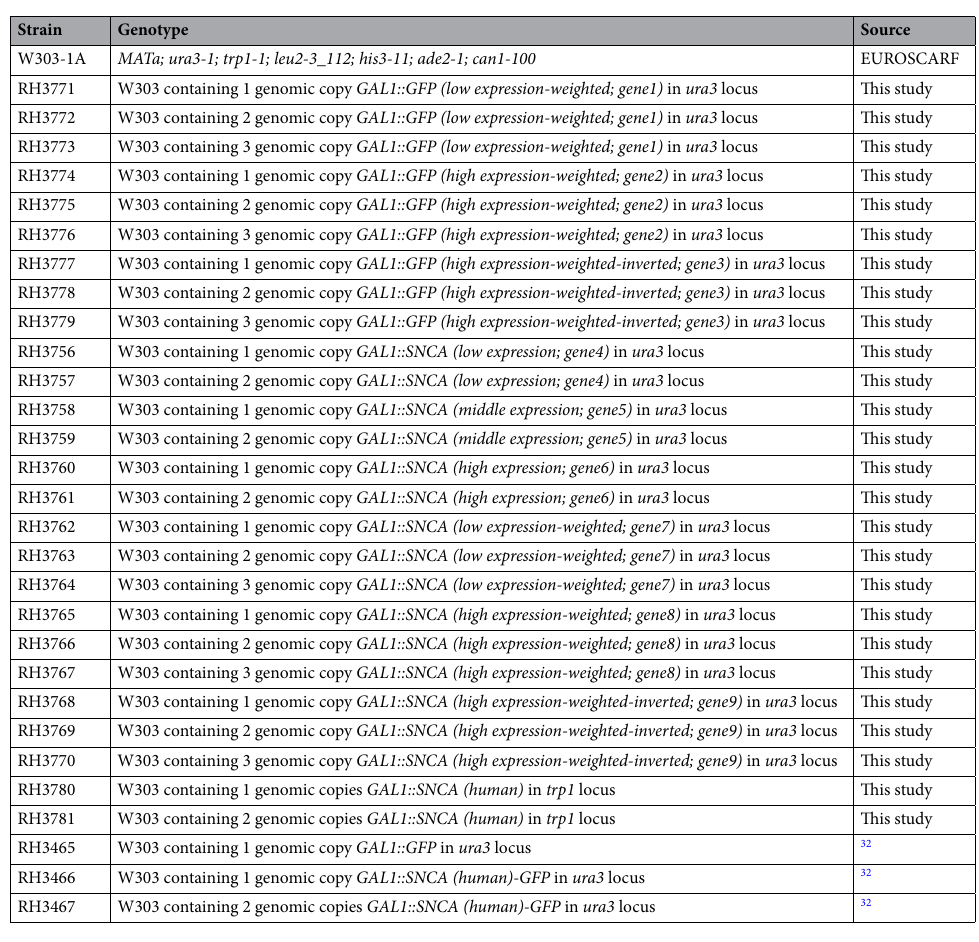
Table 2. Yeast strains used in this